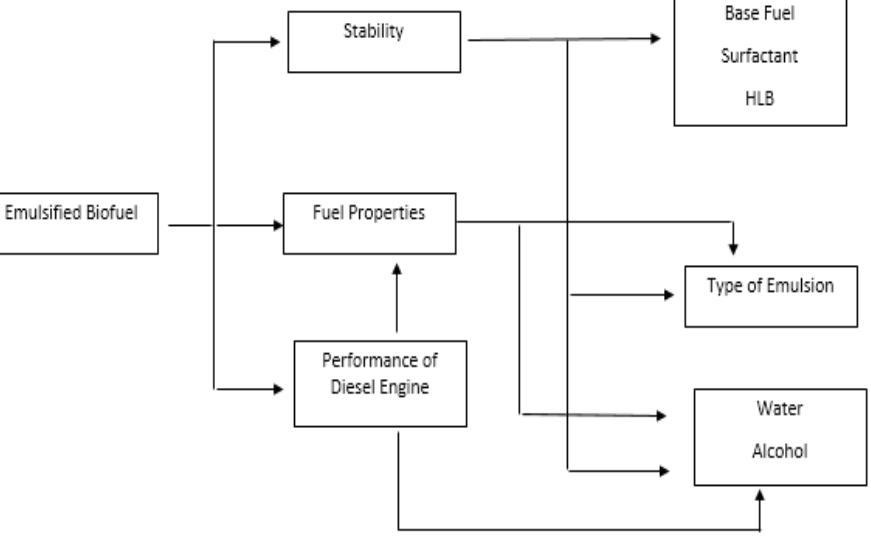
Figure 7. The interrelationship between the emulsion constituent